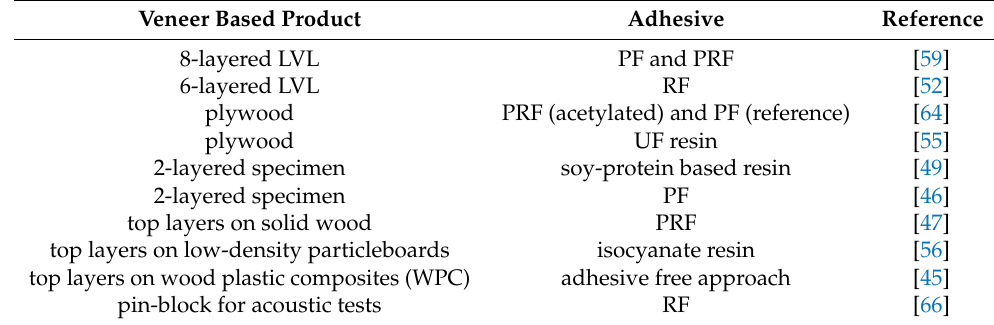
Table 2. Bonding of acetylated veneer—An overview of selected acetylated veneer-based products (phenol-formaldehyde (PF); phenol-resorcinol-formaldehyde (PRF); resorcinol-formaldehyde (RF); urea-formaldehyde (UF)).